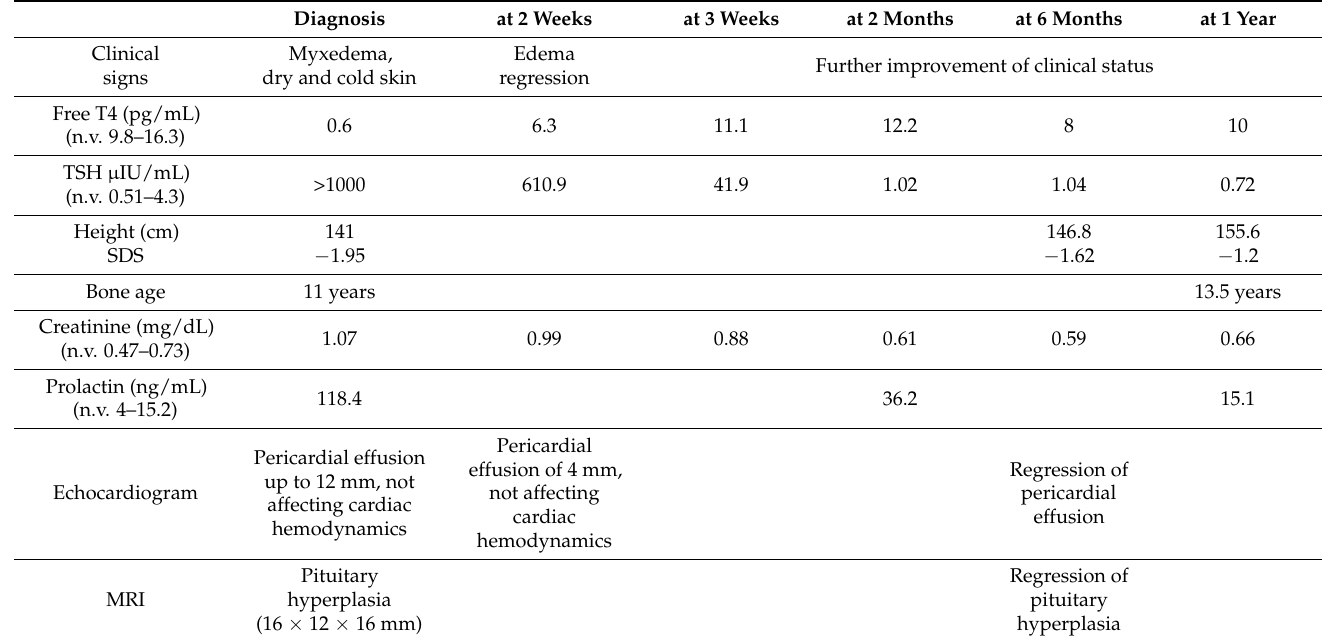
Table 1. Clinical and biochemical–hormonal data from diagnosis during